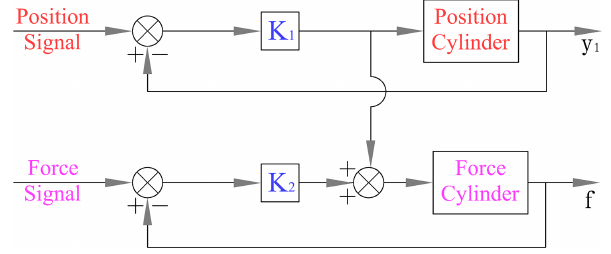
Figure 6. Schematic diagram of force–position control parallel